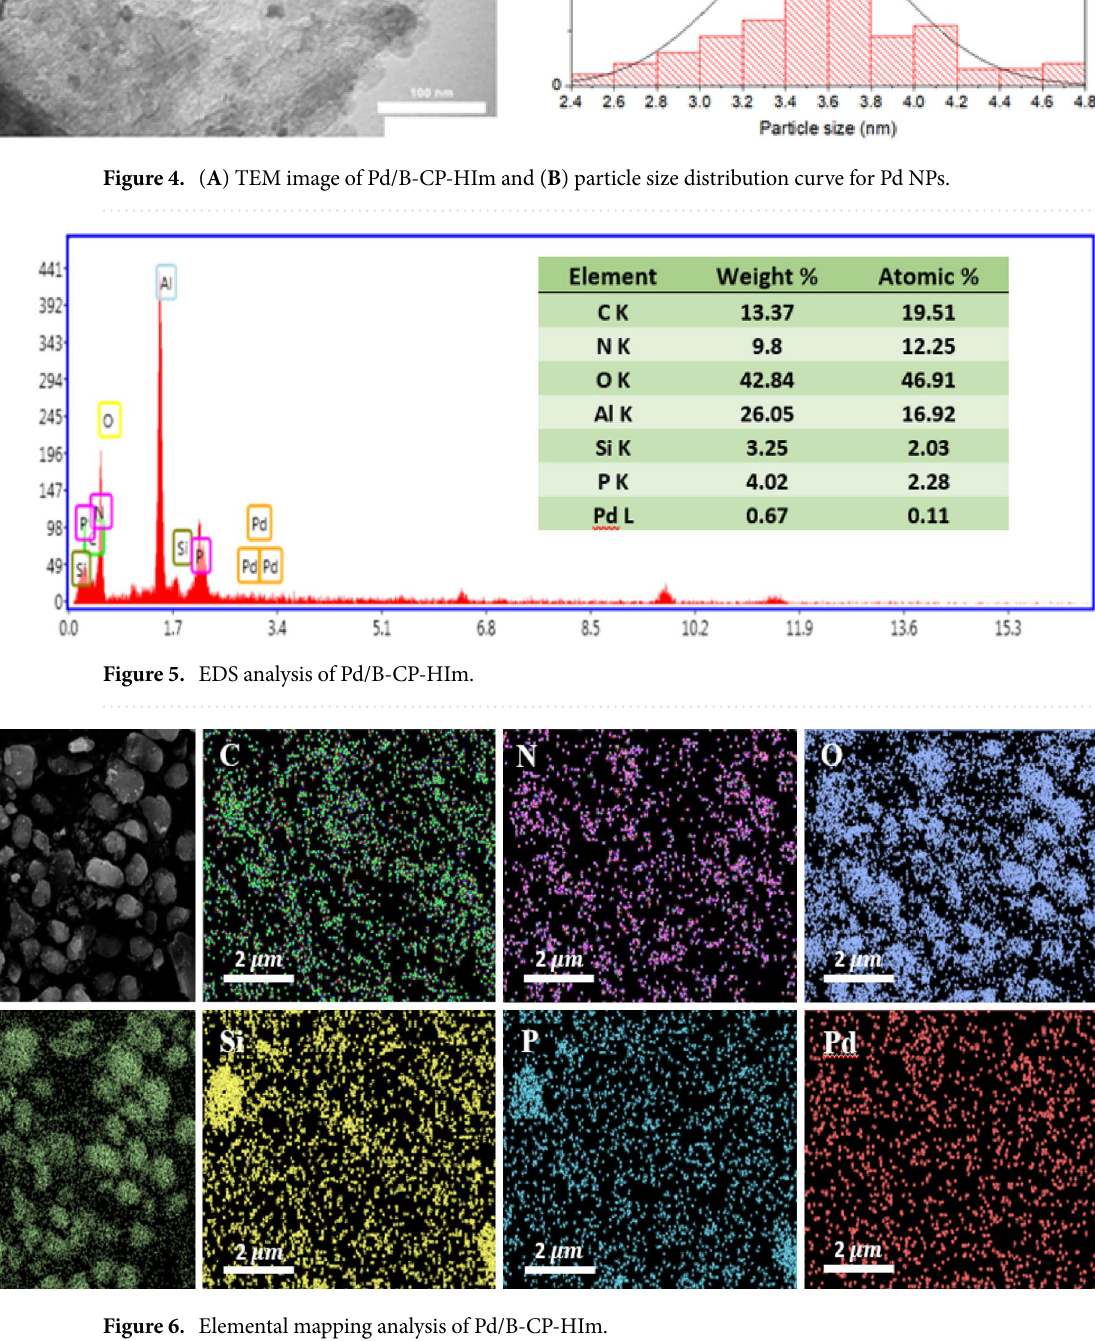
Figure 6. Elemental mapping analysis of